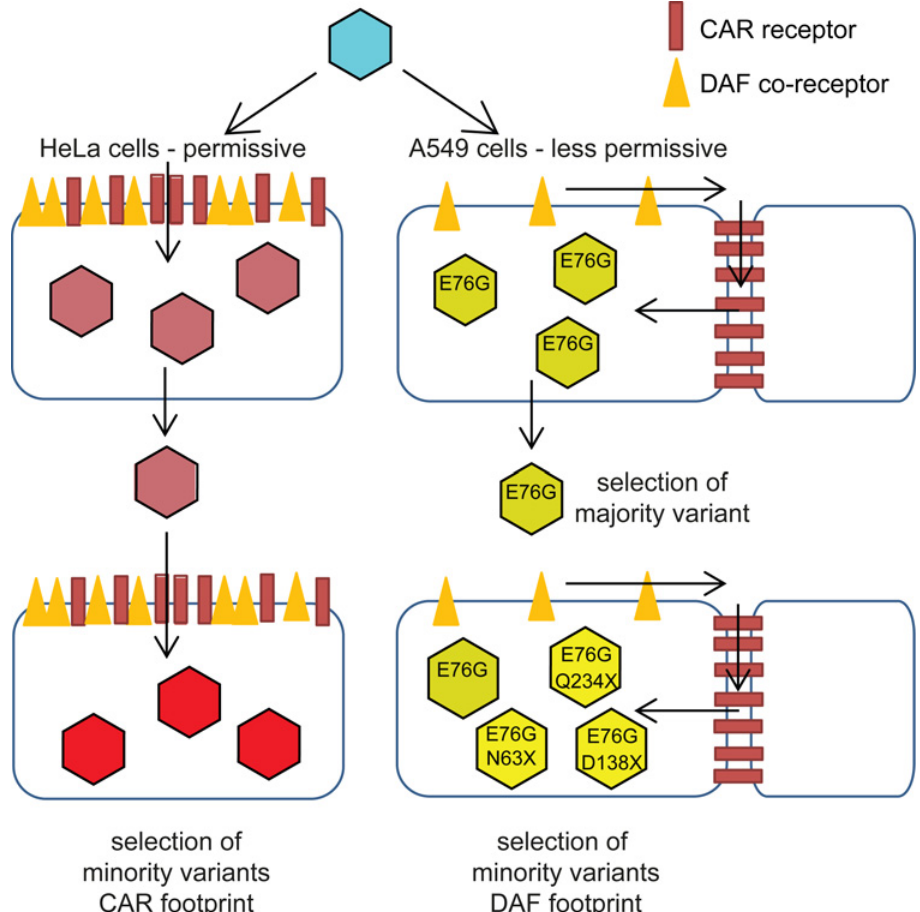
Fig 6. Schematic of CVB3 adaptation to differently permissive environments. In the permissive HeLa cell type, where the both CAR and DAF are highly and ubiquitously expressed, CVB3 accumulates CAR- and CAR/DAF-specific minority variants. In the less permissive A549 cells, where CAR is sequestered at cell-cell junctions and DAF is poorly expressed at the surface, CVB3 first fixates the E76G DAF-specific mutation, with the strongest single contribution to fitness, and in later stages, group selection of other DAF-footprint minority variants